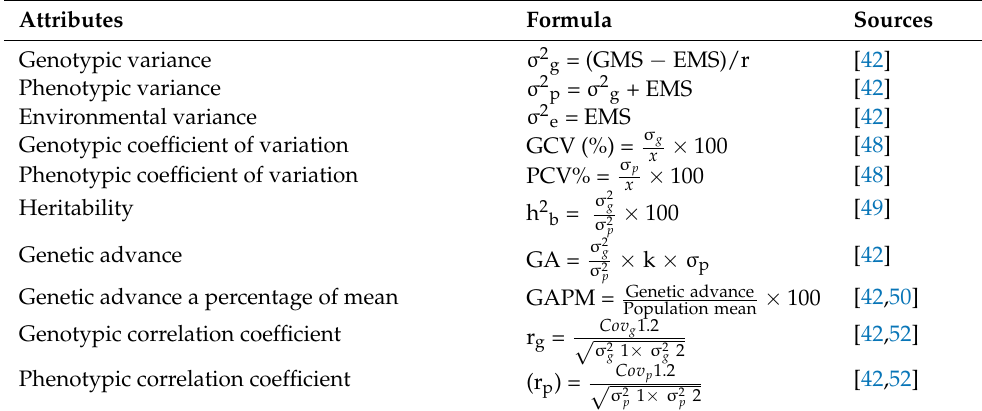
Table 6. A list of the formula used to estimate different parameters studied in the experiment.